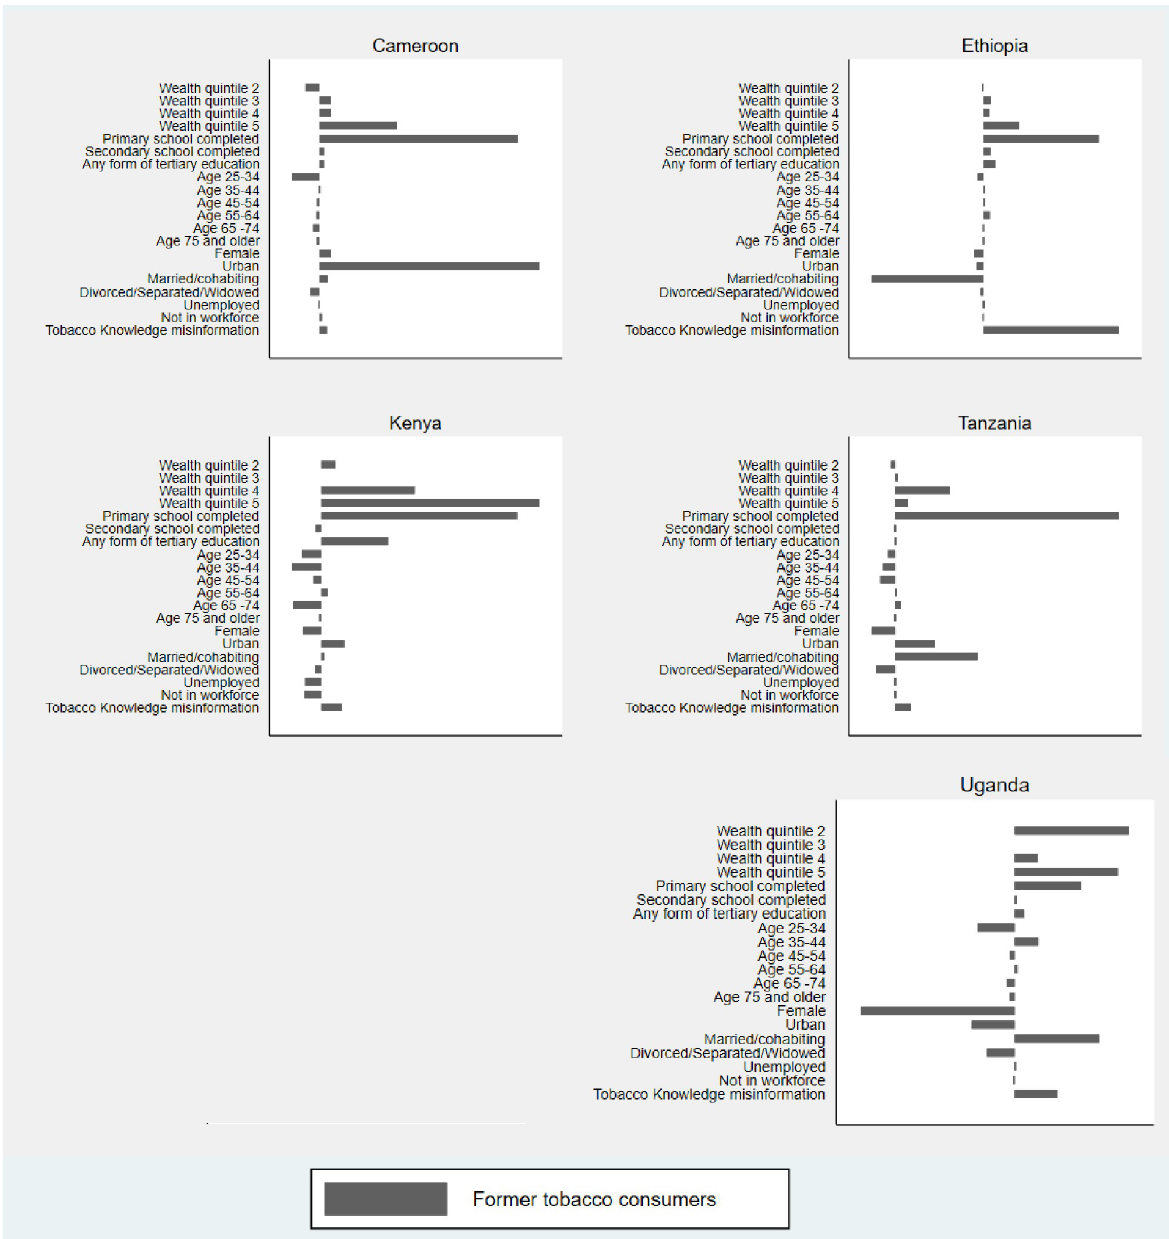
Fig 3. Percentage contribution of x in to education-related inequalities in TC F